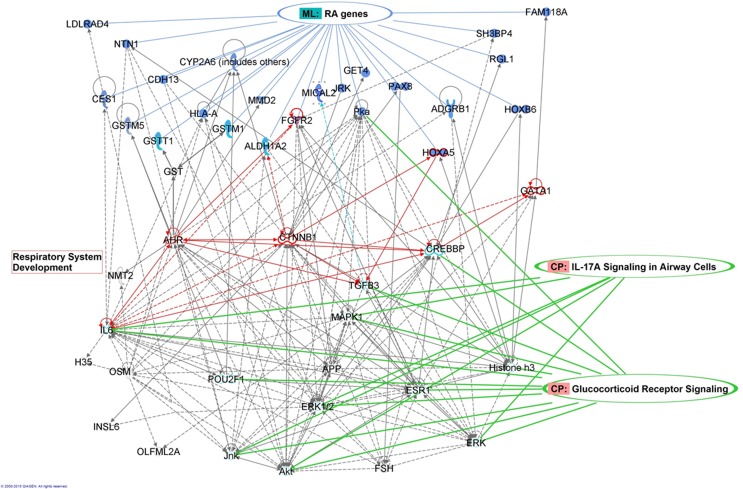
Network of genes involved in respiratory system development or inflammatory signaling.Twenty three of the focus genes are represented.